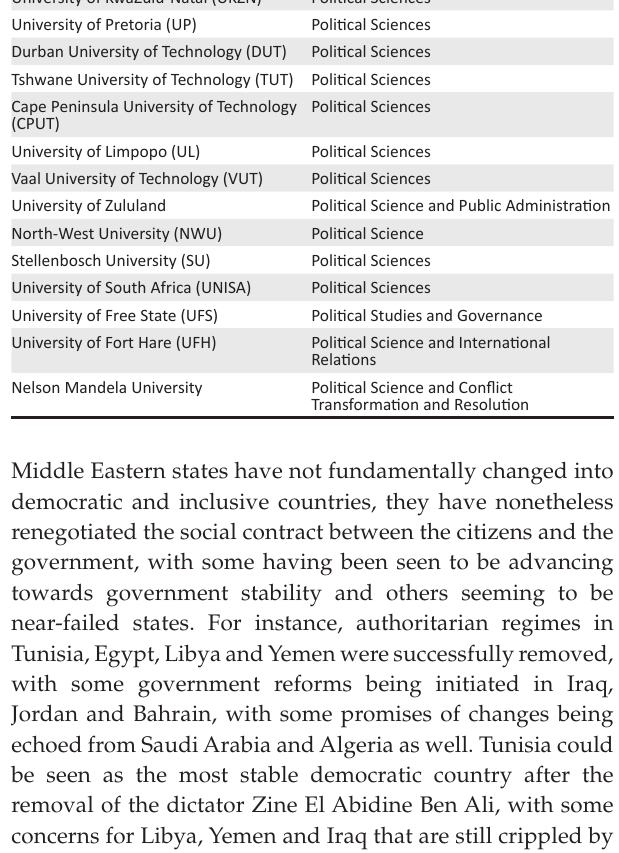
TABLE 1: South African higher education institutions that offer Political Science as a discipline or course or module. Name of the